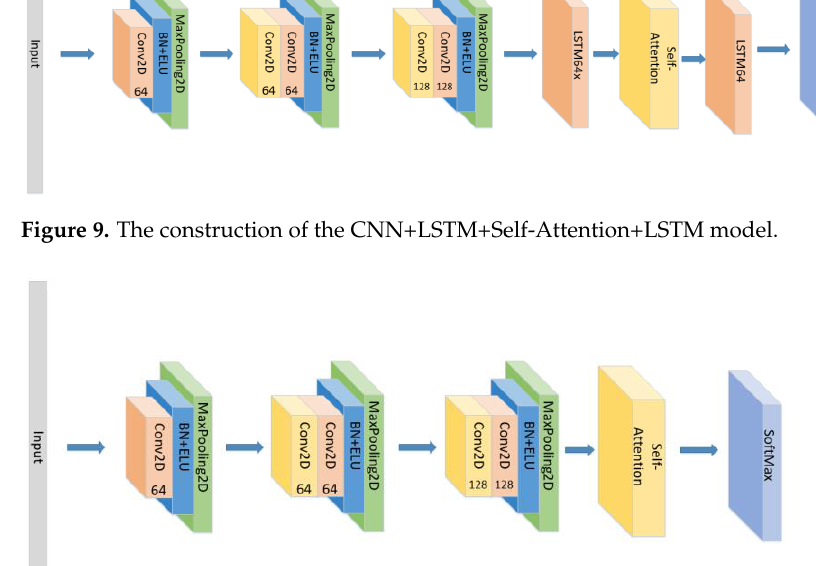
Figure 8. The construction of the CNN+LSTM × 2+Self-Attention model.